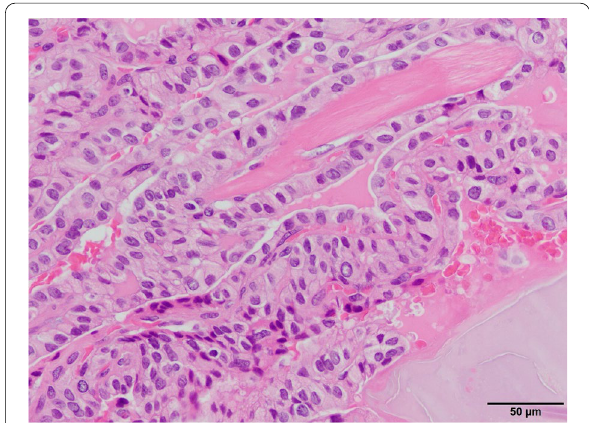
Fig. 4 Pathological findings of the thyroid tumor. Papillary carcinoma with microinvasion in the central portion of the right thyroid lobe. There is no infiltration of the surrounding connective